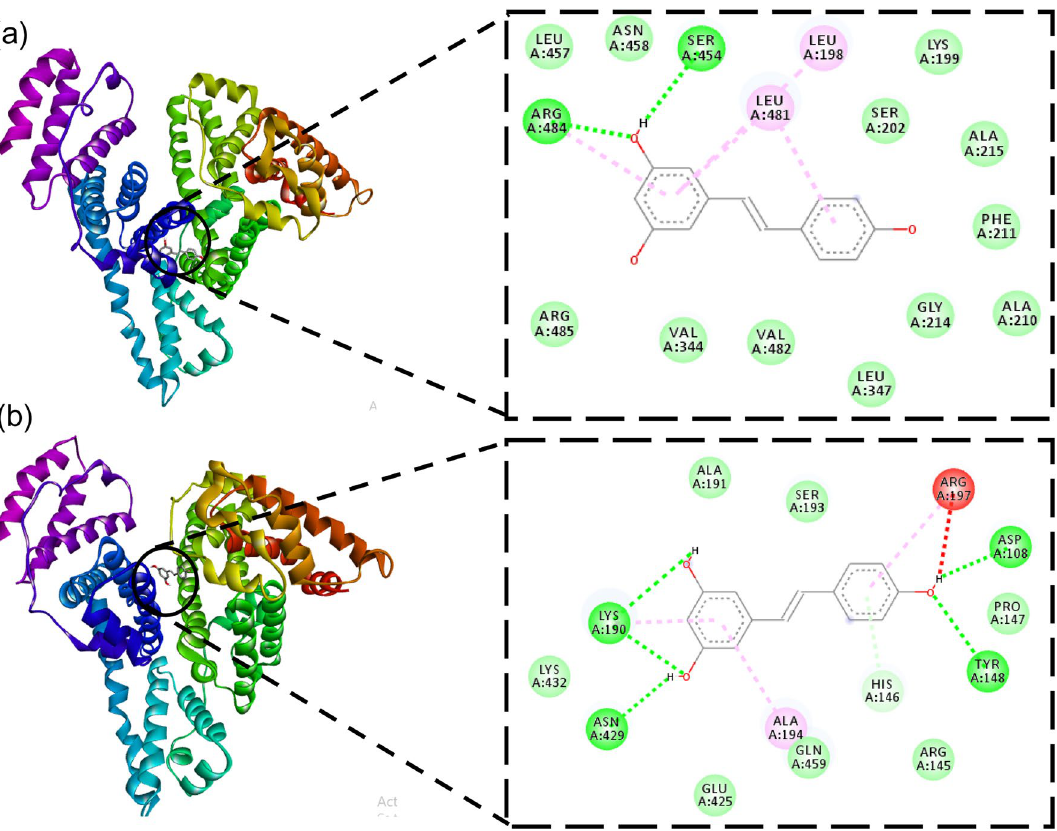
Figure 12. Molecular docking analysis for the binding of Trp-214 mutant HSA to trans -resveratrol. (a) Trp-214 is substituted with glycine residue. (b) Trp-214 is substituted with valine residue.